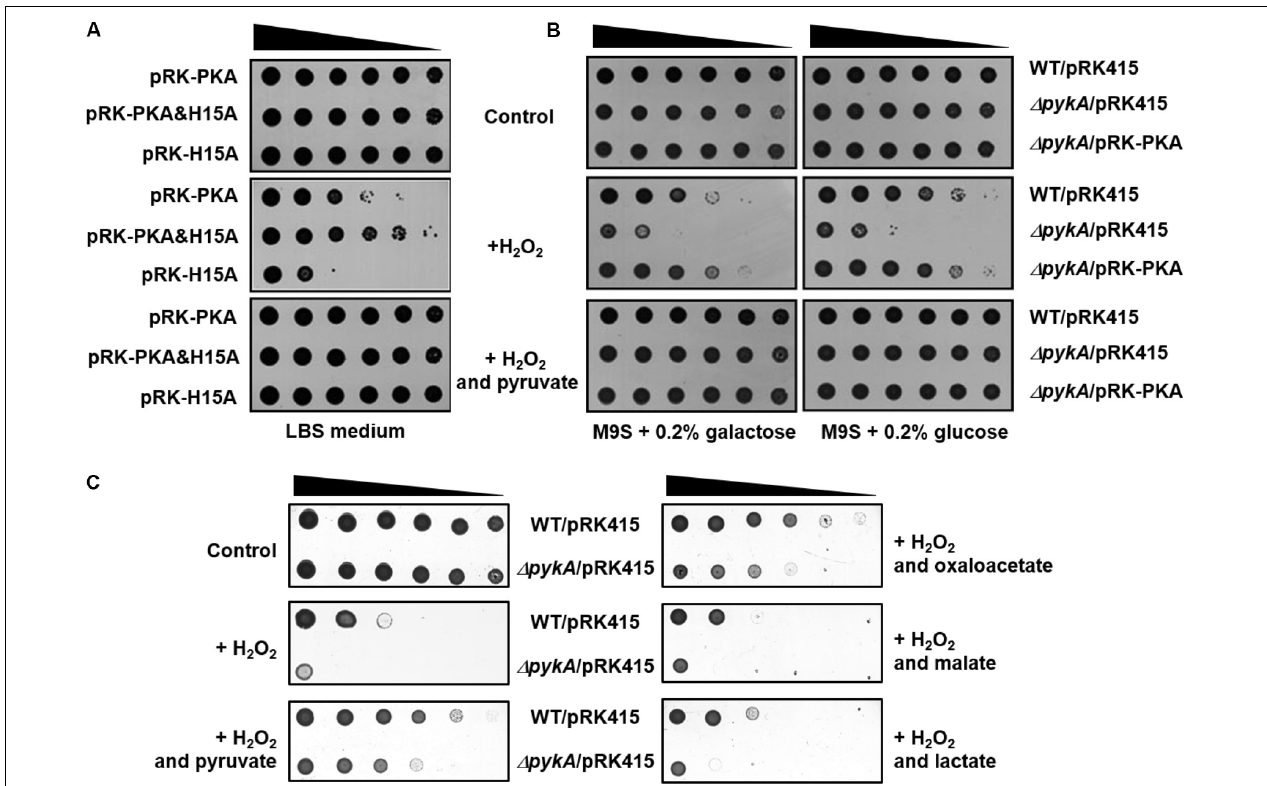
FIGURE 3 | Effects of PykA and dephospho-HPr on resistance to H 2 O 2 stress. (A) The pykA mutant cells harboring the indicated plasmids were serially diluted fourfold from 10 8 cells/ml, and 2- µ l aliquots were spotted onto LBS medium containing different combinations of H 2 O 2 and sodium pyruvate as indicated. pRK-PKA expresses V. vulnificus PykA from its own promoter and pRK-PKA&H15A expresses both PykA and HPr(H15A) (a phosphorylation site mutant mimicking the dephosphorylated form) from their own promoters. (B) The indicated strains were serially diluted fourfold from 10 8 cells/ml, and 2- µ l aliquots were spotted onto M9S medium containing a carbohydrate, H 2 O 2 and sodium pyruvate either alone or in different combinations as indicated. It should be noted that M9S agar plates were supplemented with H 2 O 2 at half the concentration added to LBS plates because cells were more sensitive to H 2 O 2 in M9S plates than in LBS plates. (C) The indicated strains were serially diluted fourfold from 10 8 cells/ml, and 2- µ l aliquots were spotted onto LBS medium containing 0.25 mM H 2 O 2 and 0.25 mM indicated supplements. Representative data from at least three independent experiments are